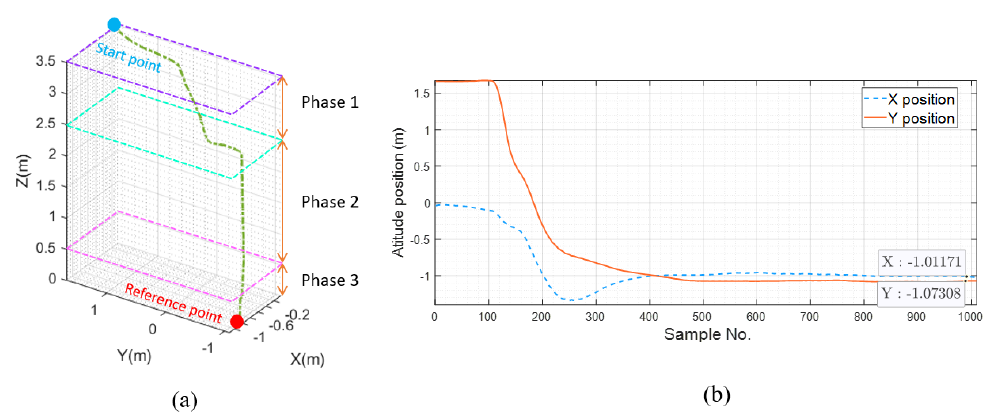
Figure 7. UAV auto-landing in the simulation environment: ( a ) Environment setting with full-scale platform mockup; ( b ) Detected tags from the camera.